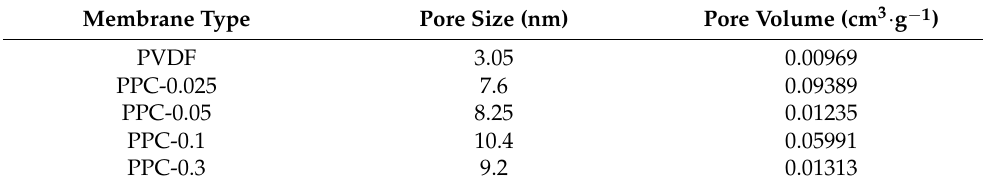
Table 5. BET Pore size and Pore volume